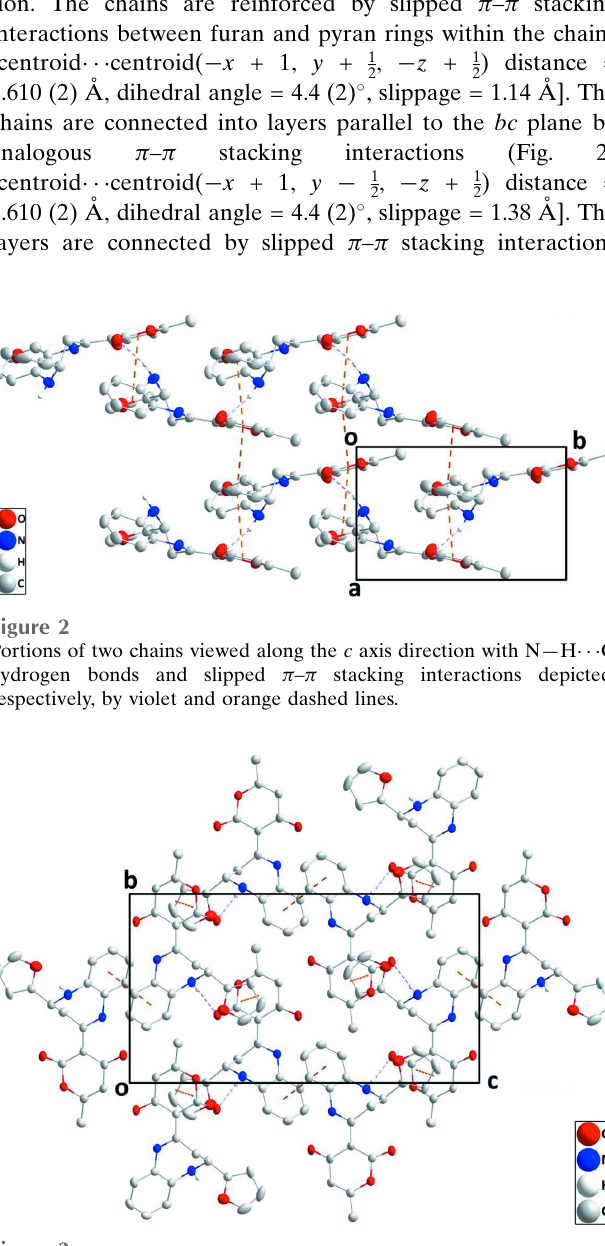
Figure 3 Packing viewed along the a- axis direction with intermolecular inter- actions depicted as in Fig. 2.